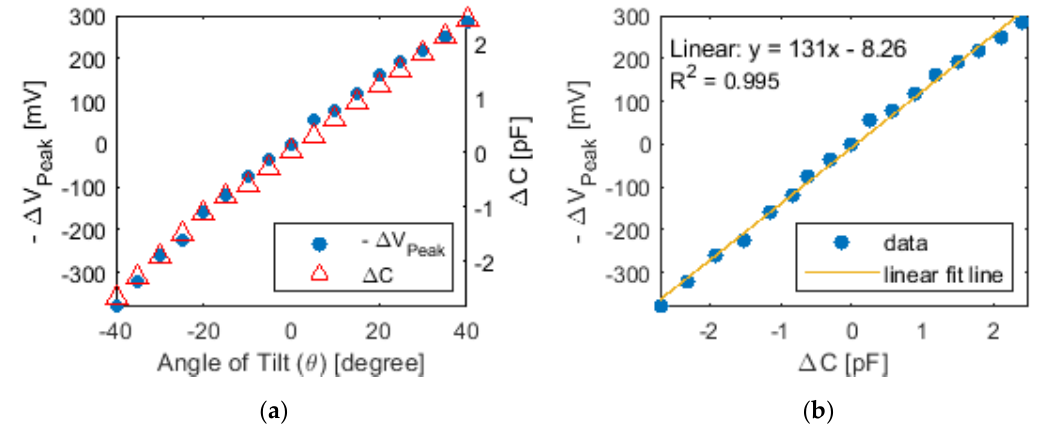
Figure 11. ( a ) The negative change in peak voltages of Reflected wave #1 from ETDR tests and the capacitance change of the tilt sensor are overlaid and plotted with respect to the angle of tilt. ( b ) Replotting the same set of data with its linear best-fit line confirmed linear tilt sensing performance.